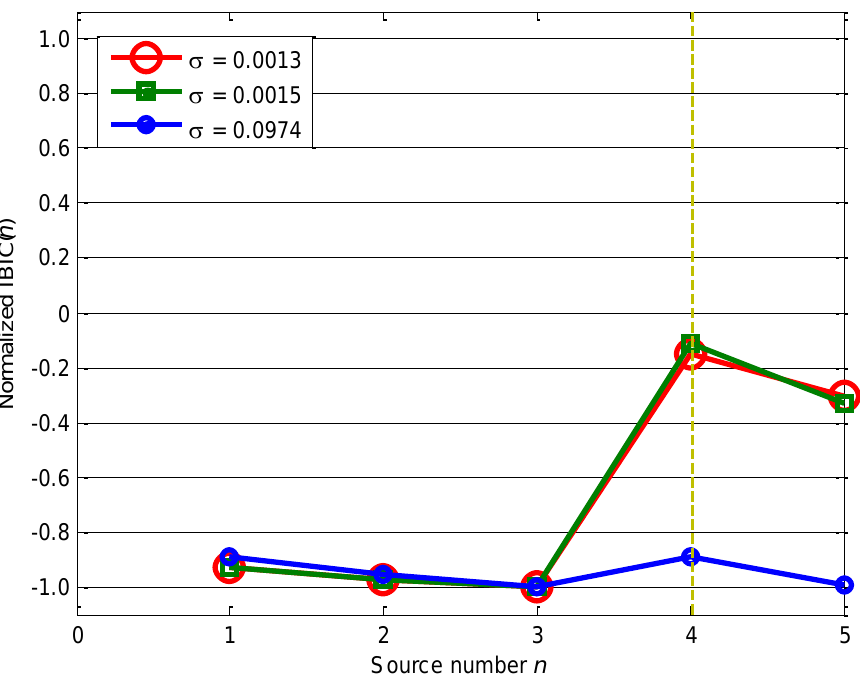
Figure 8. Source number estimation by